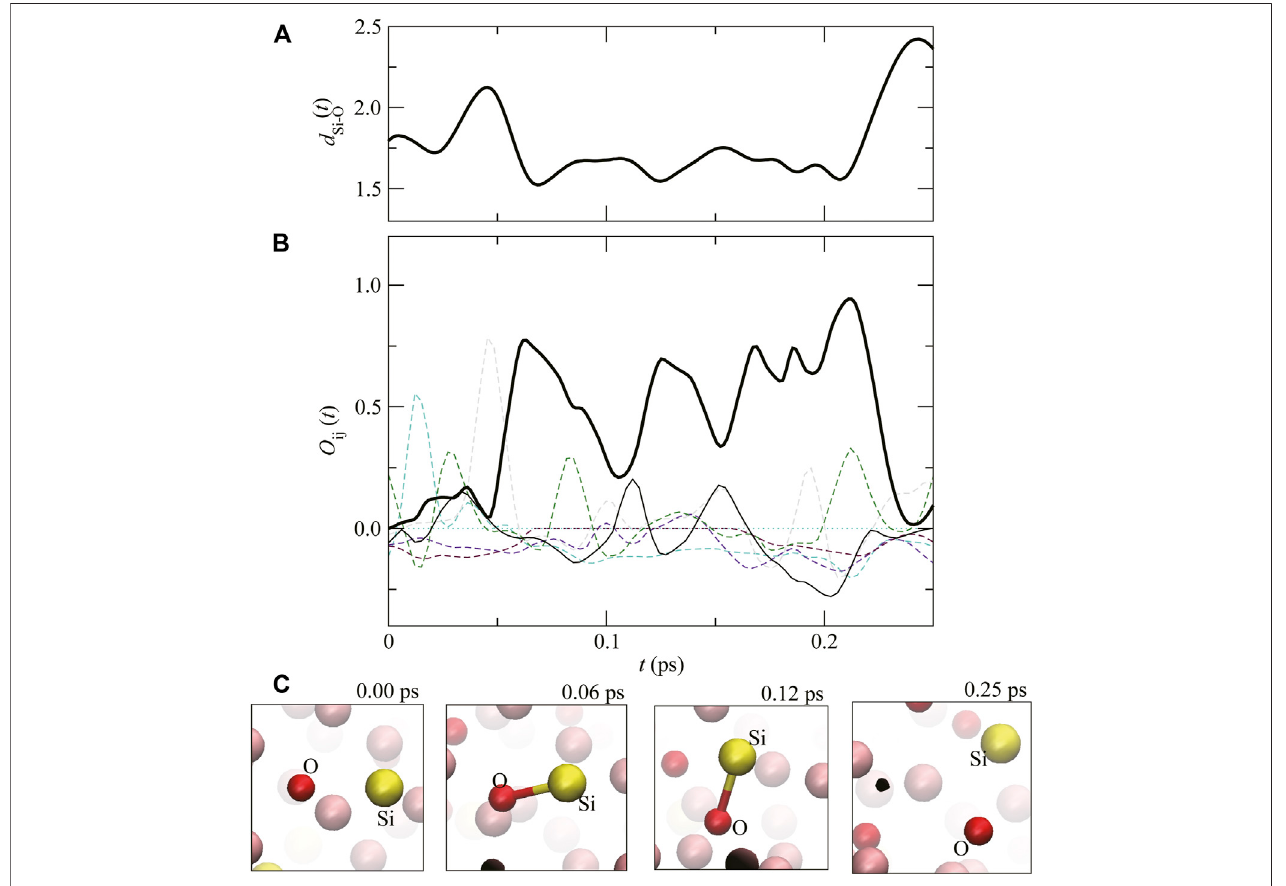
FIGURE 6 | (A) The time evolution of distance between Si and O atoms, d Si – O ( t ), and (B) the overlap population O Si − O ( t ) (Thick solid line). Dashed lines show O Si − Fe ( t ) . (C) Atomic con fi gurations around Si and O at t = 0.00, 0.06, 0.12 and 0.25 ps. The pink, yellow and red spheres correspond to Fe, Si and O atoms, respectively.